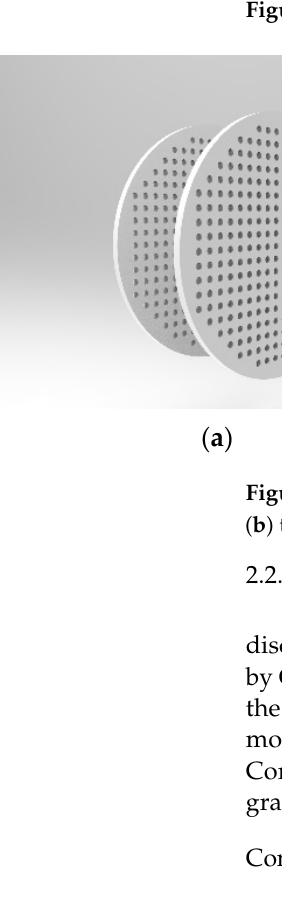
Figure 4. The structure of the porous steady flow plates. ( a ) Two layers of the steady flow plates, ( b ) the installation of the steady flow plates.